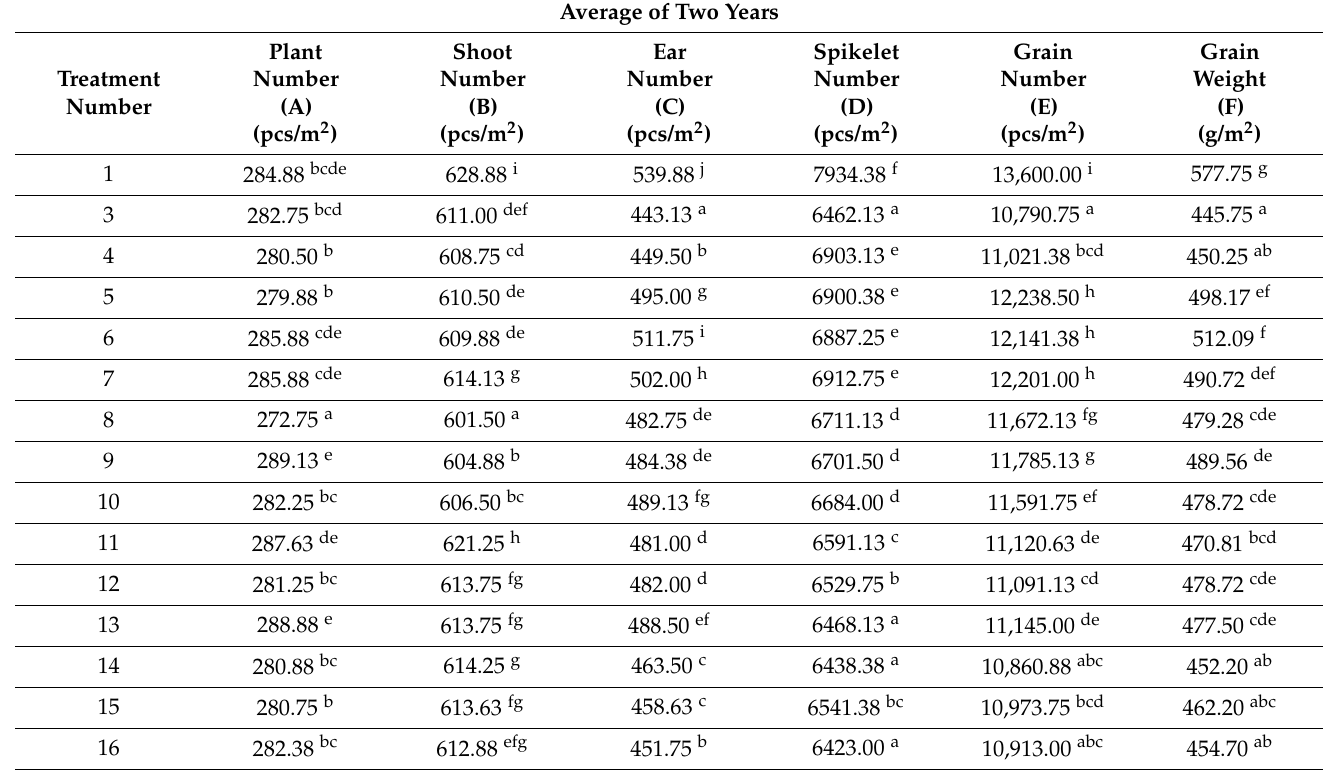
Table 11. Changes in winter wheat ( Triticum aestivum L.) yield components (A, B, C, D, E, F) in the different